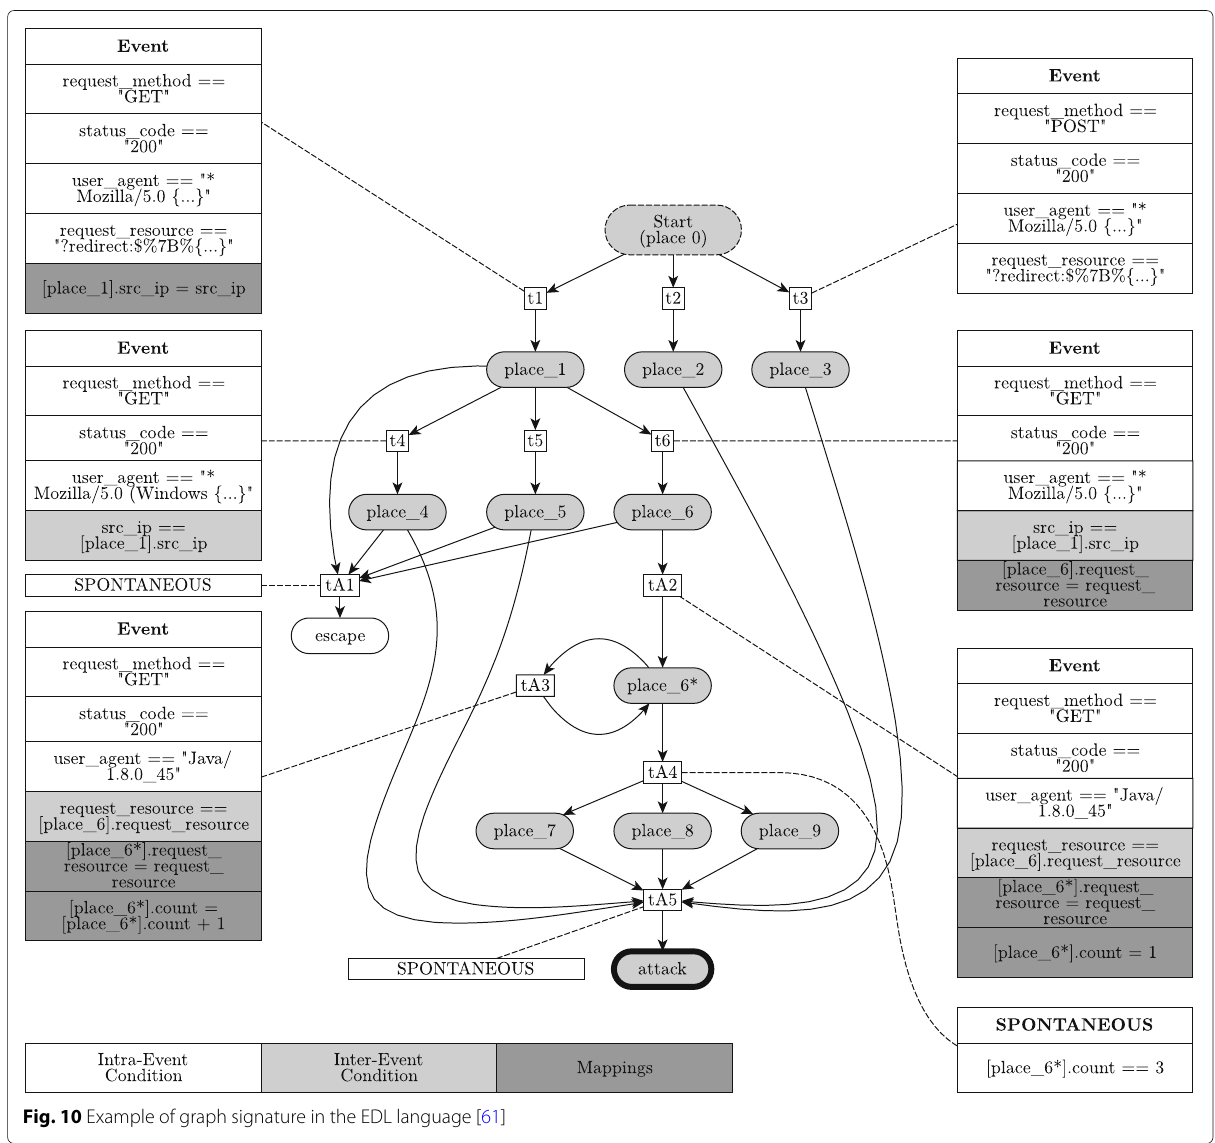
Fig. 10 Example of graph signature in the EDL language [61]